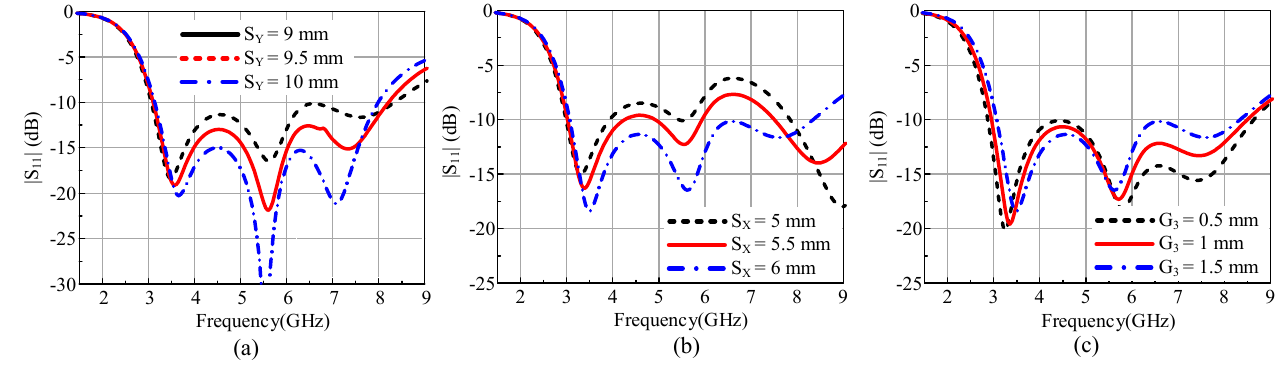
Figure 5. |S 11 | analysis for different ( a ) length of rectangular patch Sy , ( b ) width of rectangular patch Sx , and ( c ) width of slot G 3 .